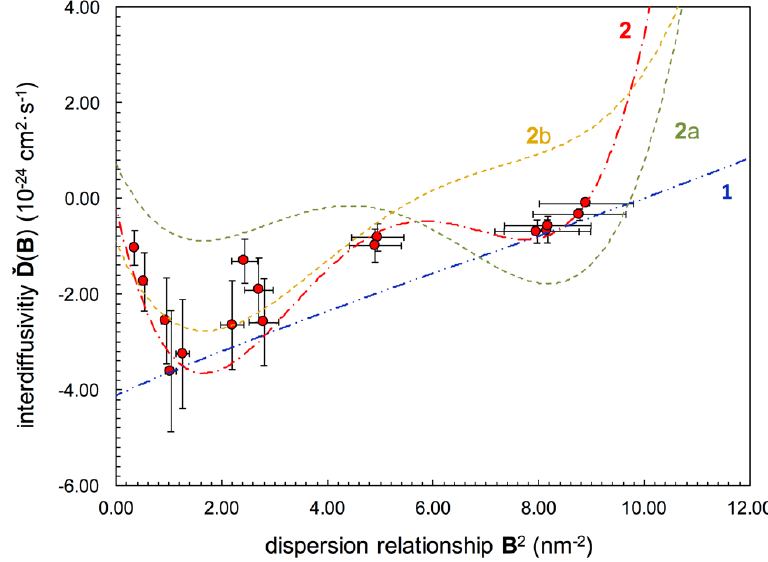
Figure 4. The interdiffusivity Ď ( B ) (10 −24 cm 2 ·s −1 ) is plotted as a function of the dispersion relationship B 2 (nm −2 ) for Cu-Ni(Fe) as computed using Figure 3 amplification values R ( B ) (s −1 ). B 2 (nm − 2 ) for Cu-Ni(Fe) as computed using Figure 3 amplification values R ( B ) (s − 1